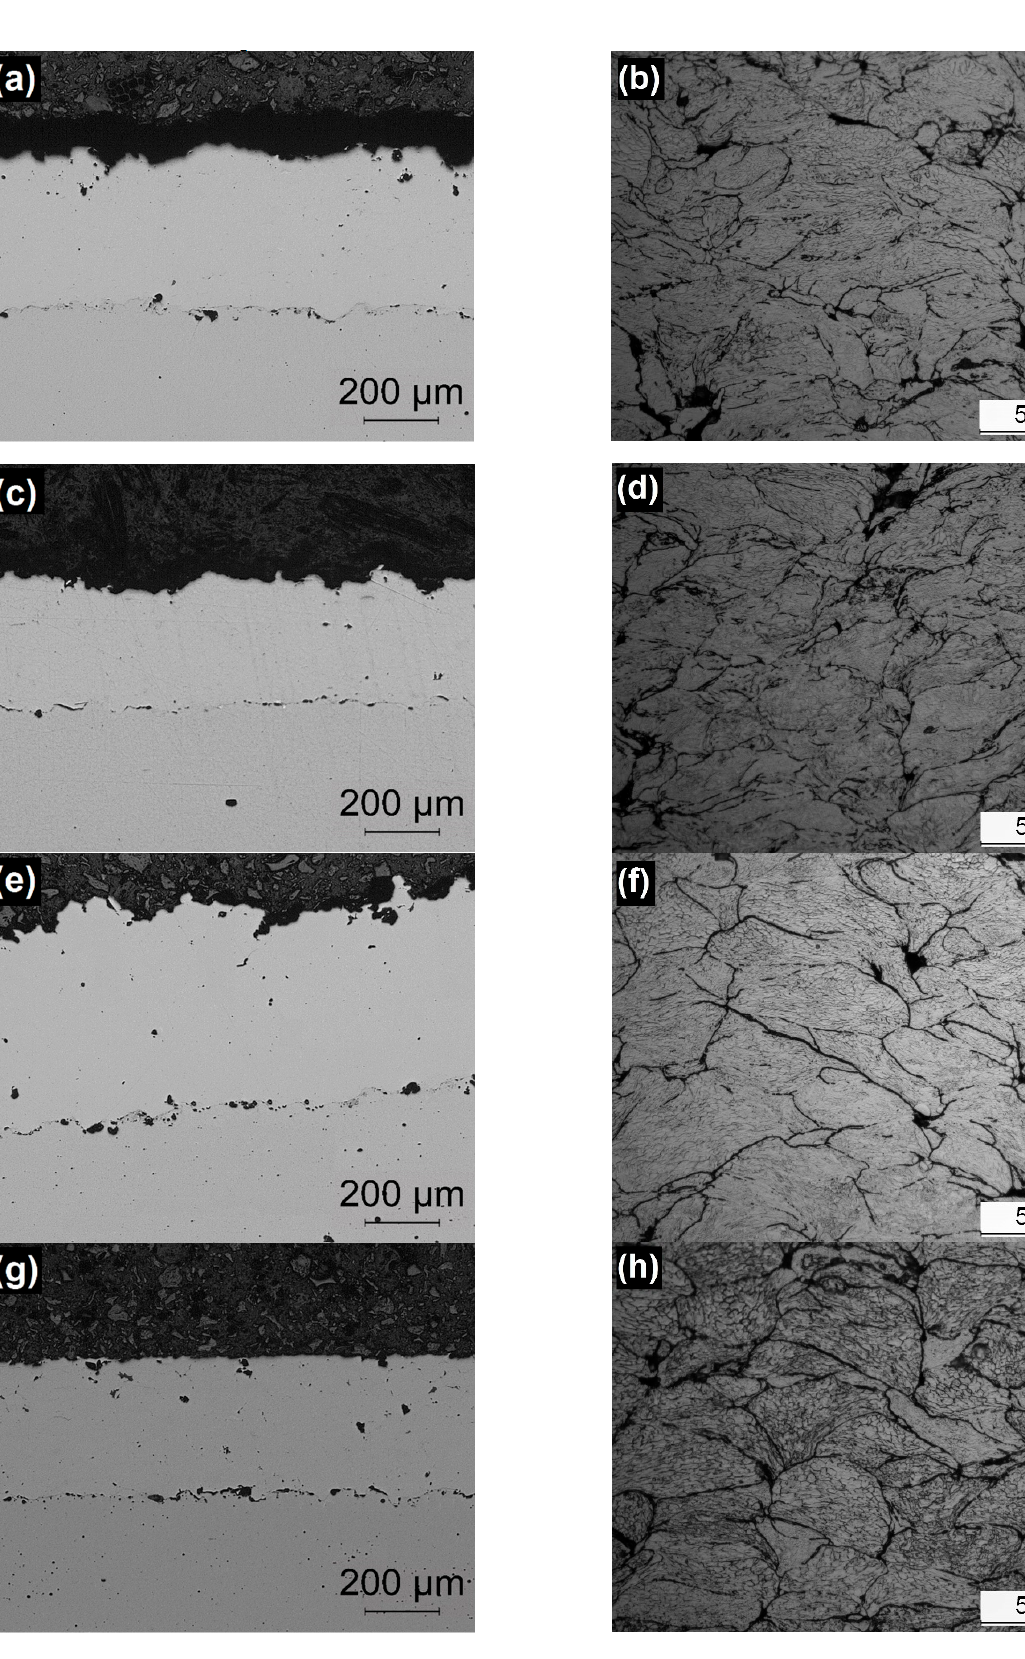
Figure 5. OM of cross-sectional image of the CGS coatings obtained at 50× as polished and 500× as etched. Powders: ( a , b ) 316L-CGS_1, ( c , d ) 316L-CGS_2, ( e , f ) 316L-HVOF, and ( g , h ) 316L-APS.